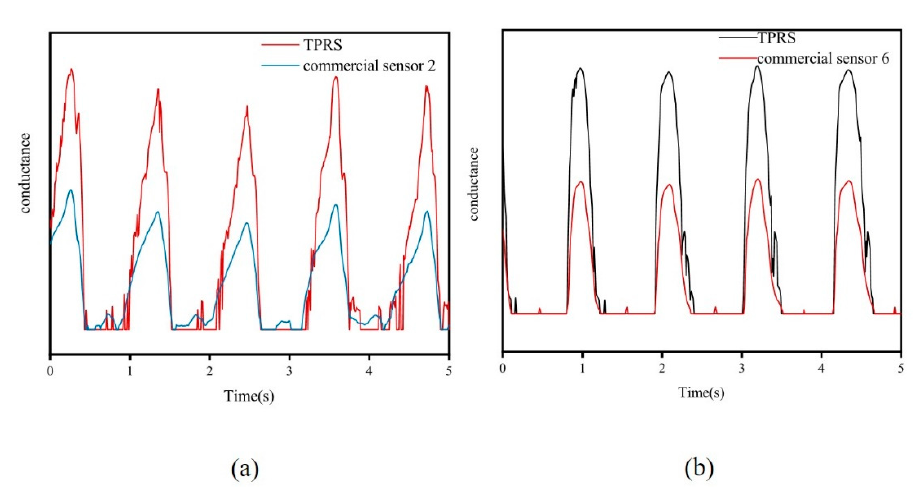
Figure 6. ( a ) commercial sensor placed over TPRS; ( b ) signals of sensor 2 and TPRS.